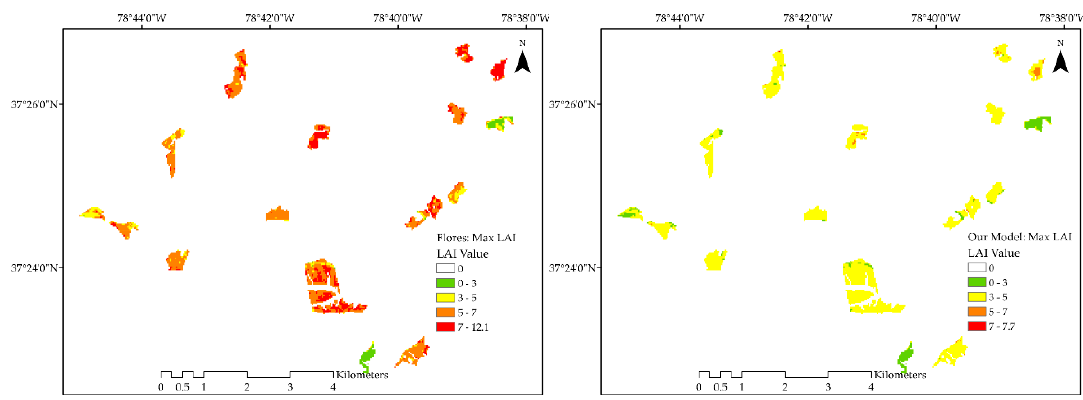
Figure 7. Maximum LAI shown for both the Flores et al. model ( left ) and our combined model using SR ( right ).